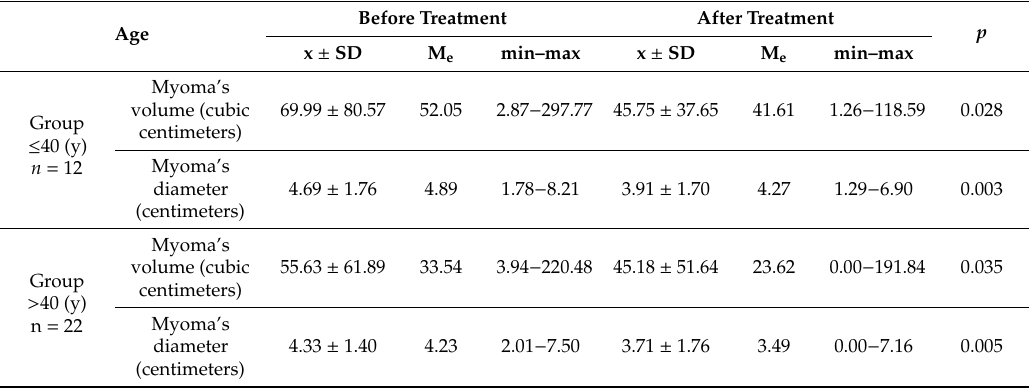
Table 4. The diameter and volume of fibroids before and after 3 months of treatment with ulipristal acetate depending on the patients’ age. In case of multiple myomas in one patient, mean value of these 2-4 myomas was